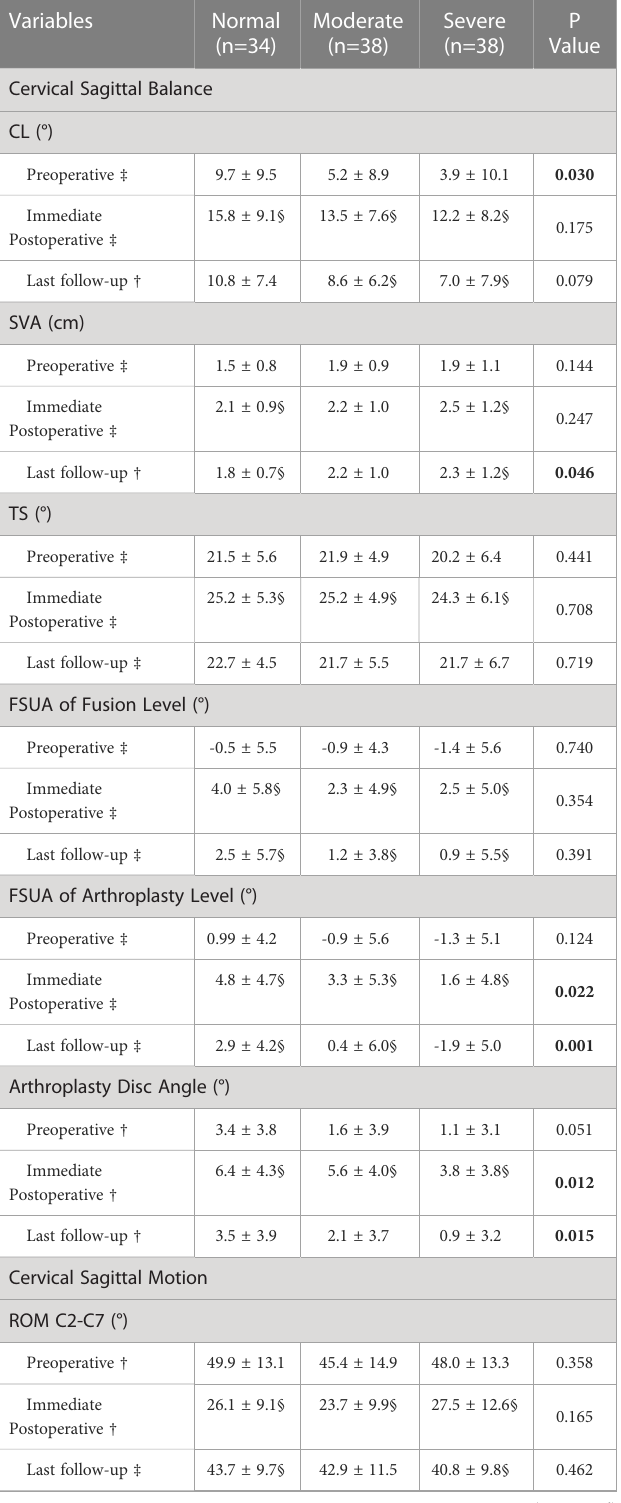
TABLE 3 Radiographical